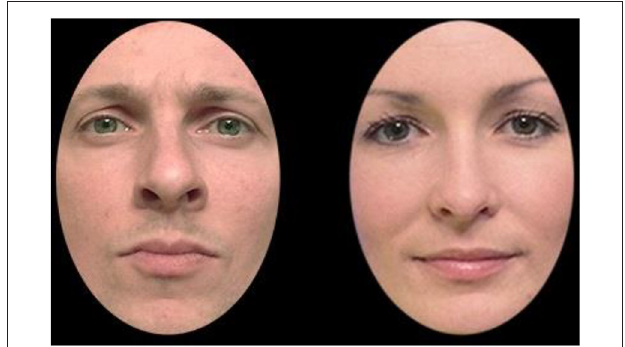
Table 3 | Discriminability (with standard errors).